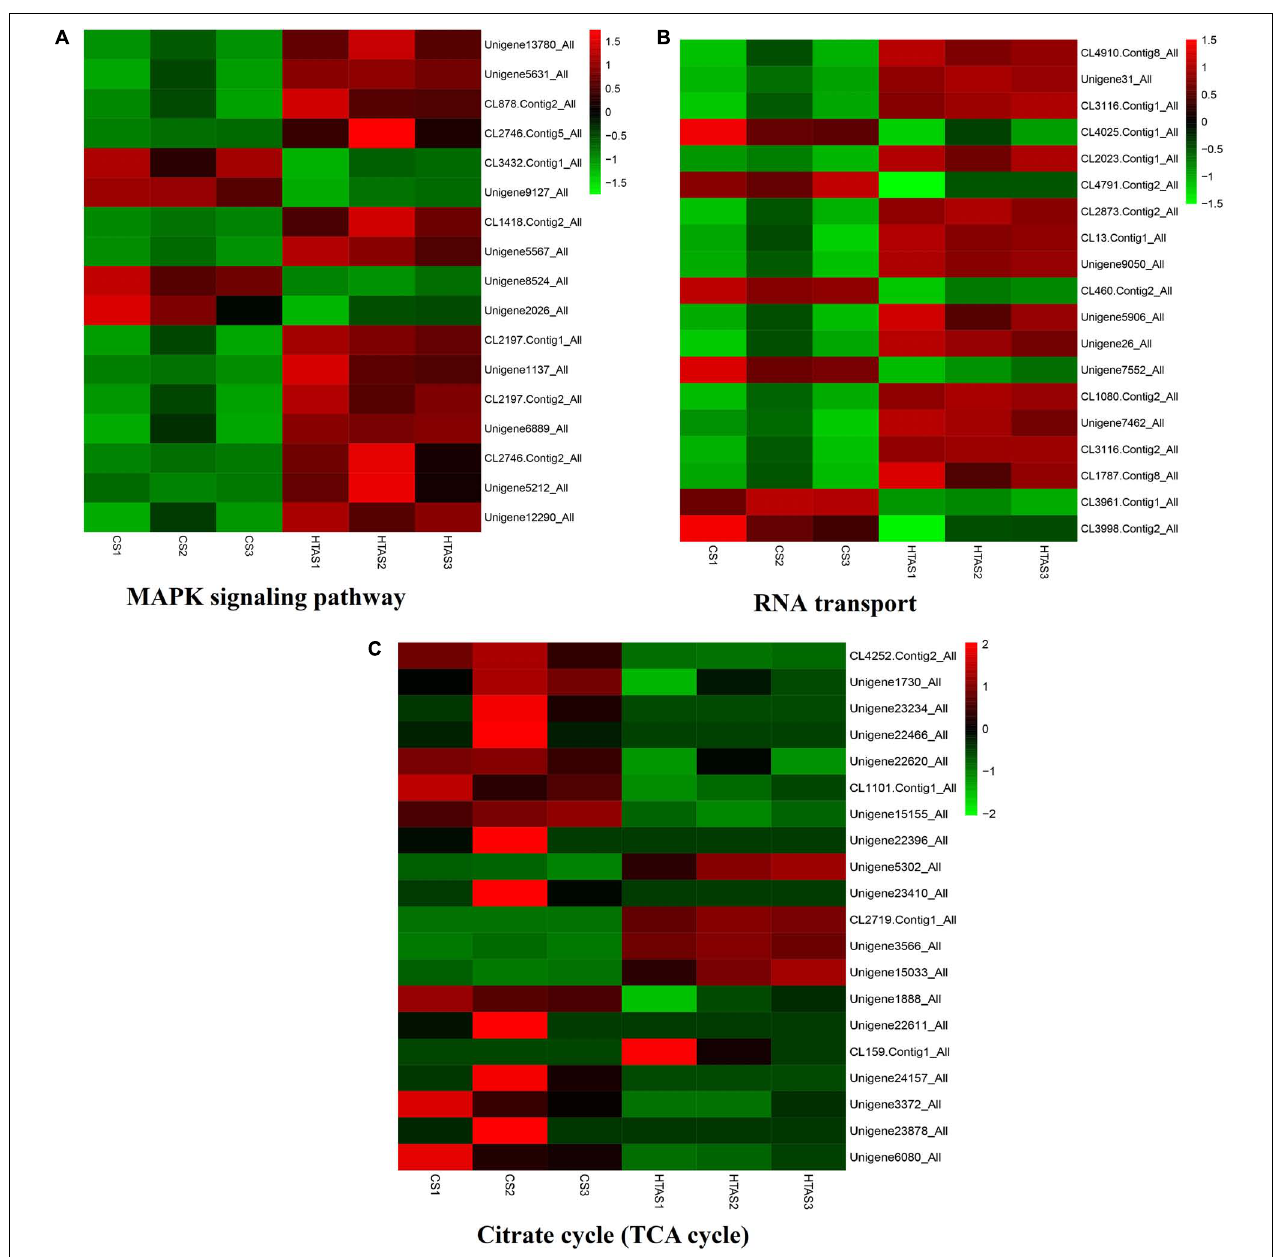
FIGURE 4 | Heat map of the expression levels of different pathways. The expression levels of some genes in “MAPK signaling pathway,” “RNA transport” and “Citrate cycle (TCA cycle)” were shown in (A–C) , respectively. The color scale is shown at the upper right, which denotes FPKM value from the lowest (green) to the highest